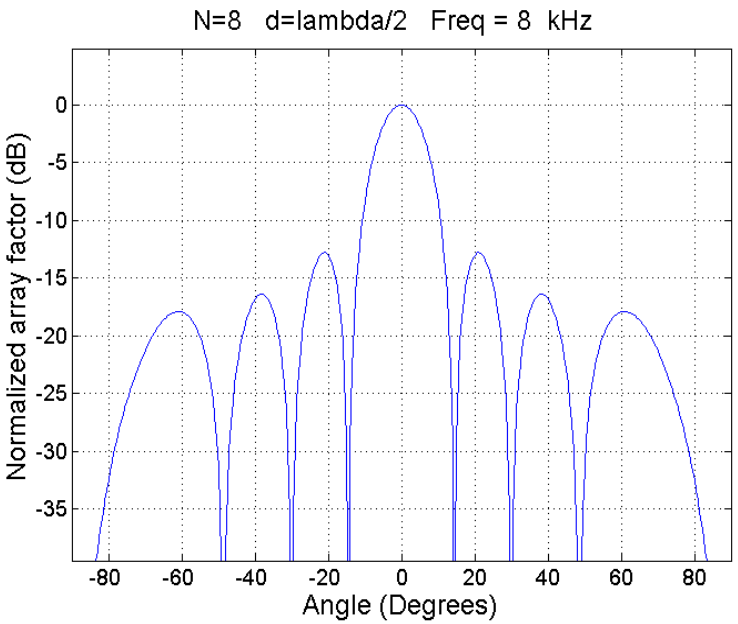
Figure 2. Beampattern for θ = 0 °